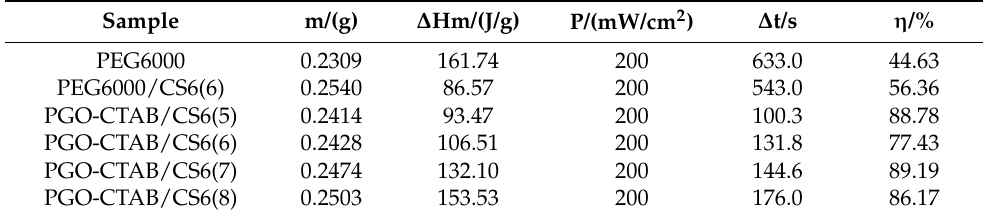
Table 7. Photo-thermal conversion performance parameters of phase change composites.